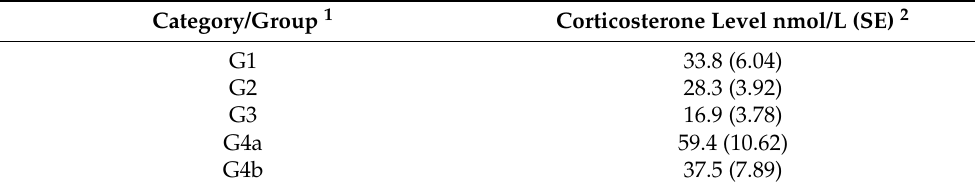
Table 3. Serum CORT levels in different groups of pigeons in all flocks